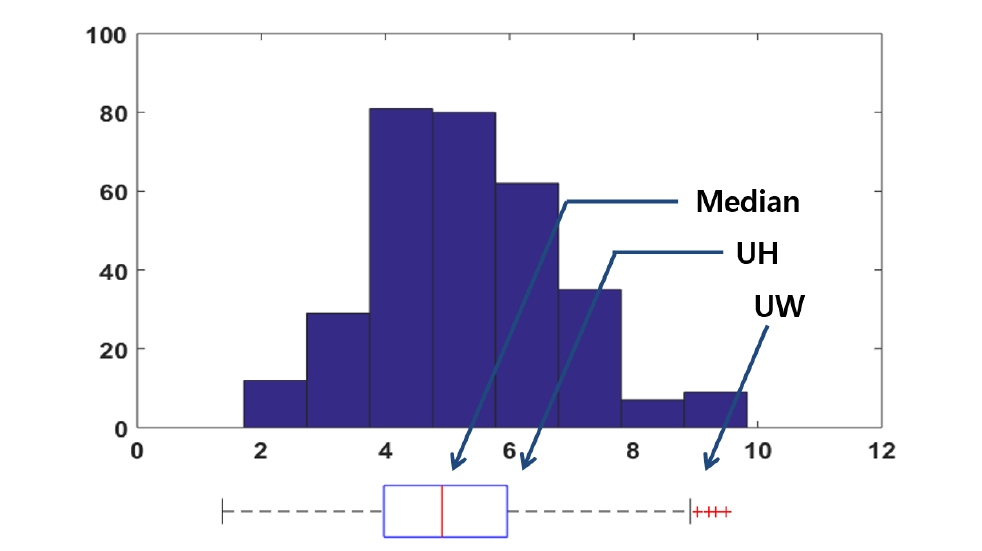
Figure 10. A histogram and boxplot analysis of manually chosen corresponding point